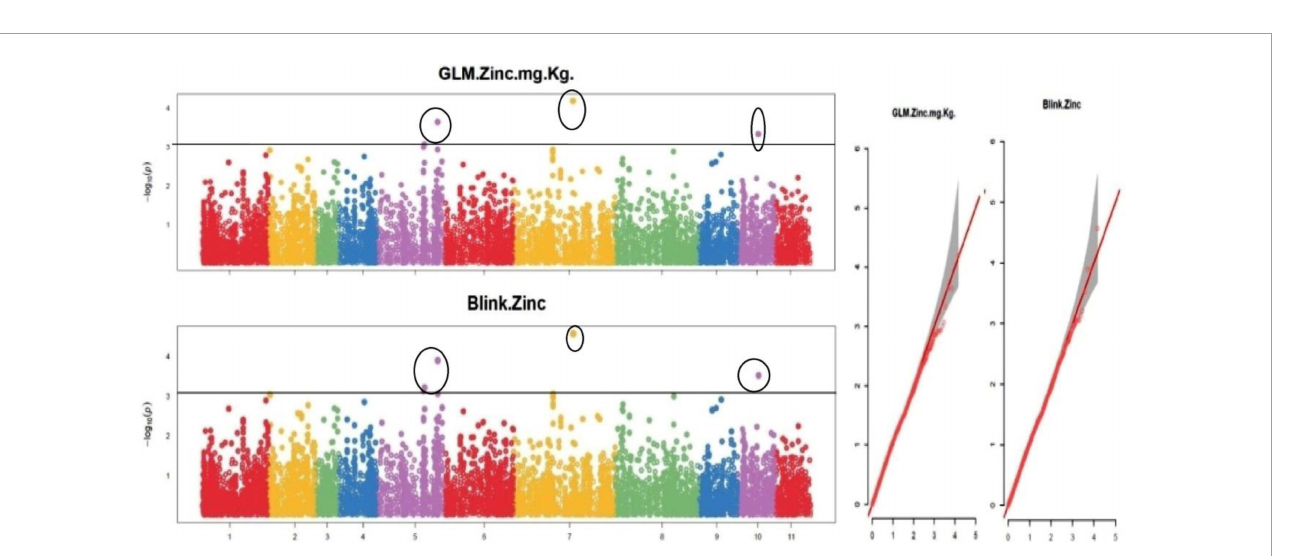
FIGURE7 Manhattan plots and Quantile-Quantile plots depicting the significant association of SNP markers with grain zinc